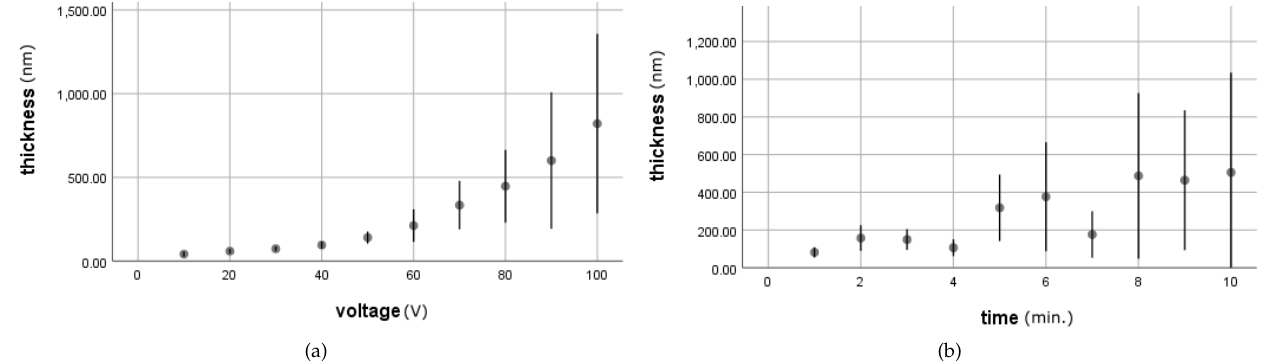
Figure 1. ( a ) Mean thickness by voltage from 10 V to 100 V ( b ) Mean thickness by time from 1 min to 10 min (line indicates 95%